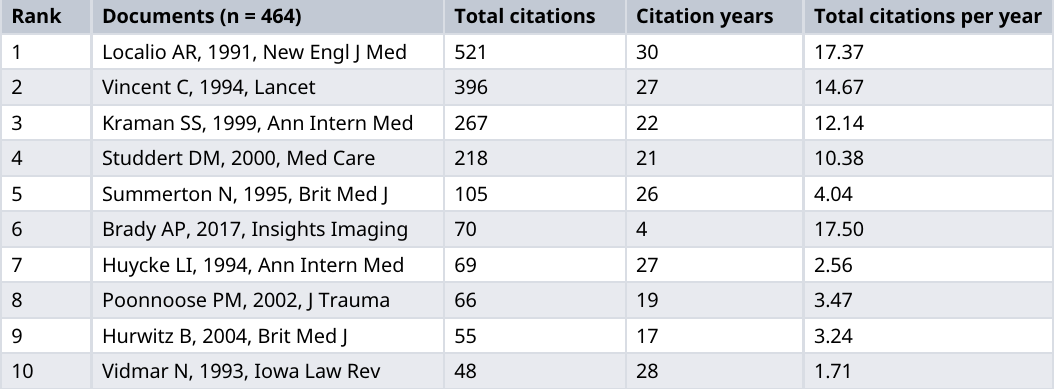
Table 7. Top ten most cited